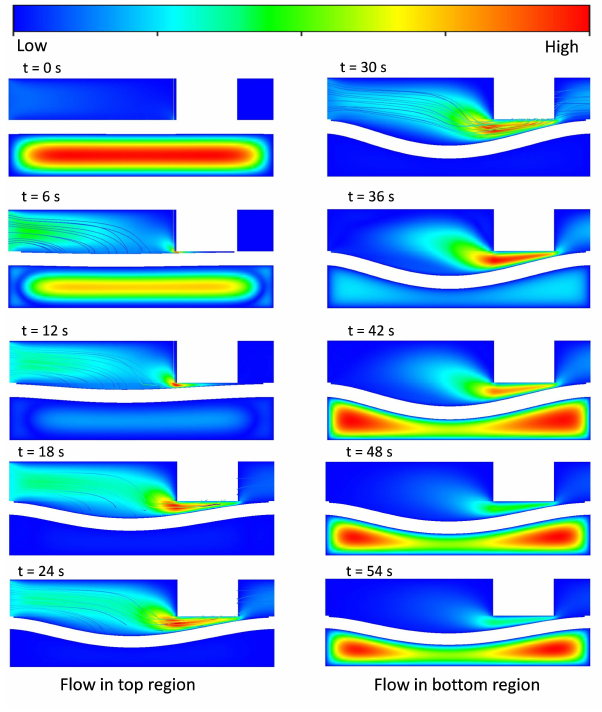
Figure 10. Velocity contours’ fields and streamlines for various time steps for L/W = 0.65 model in the A-A’ cross-sectional